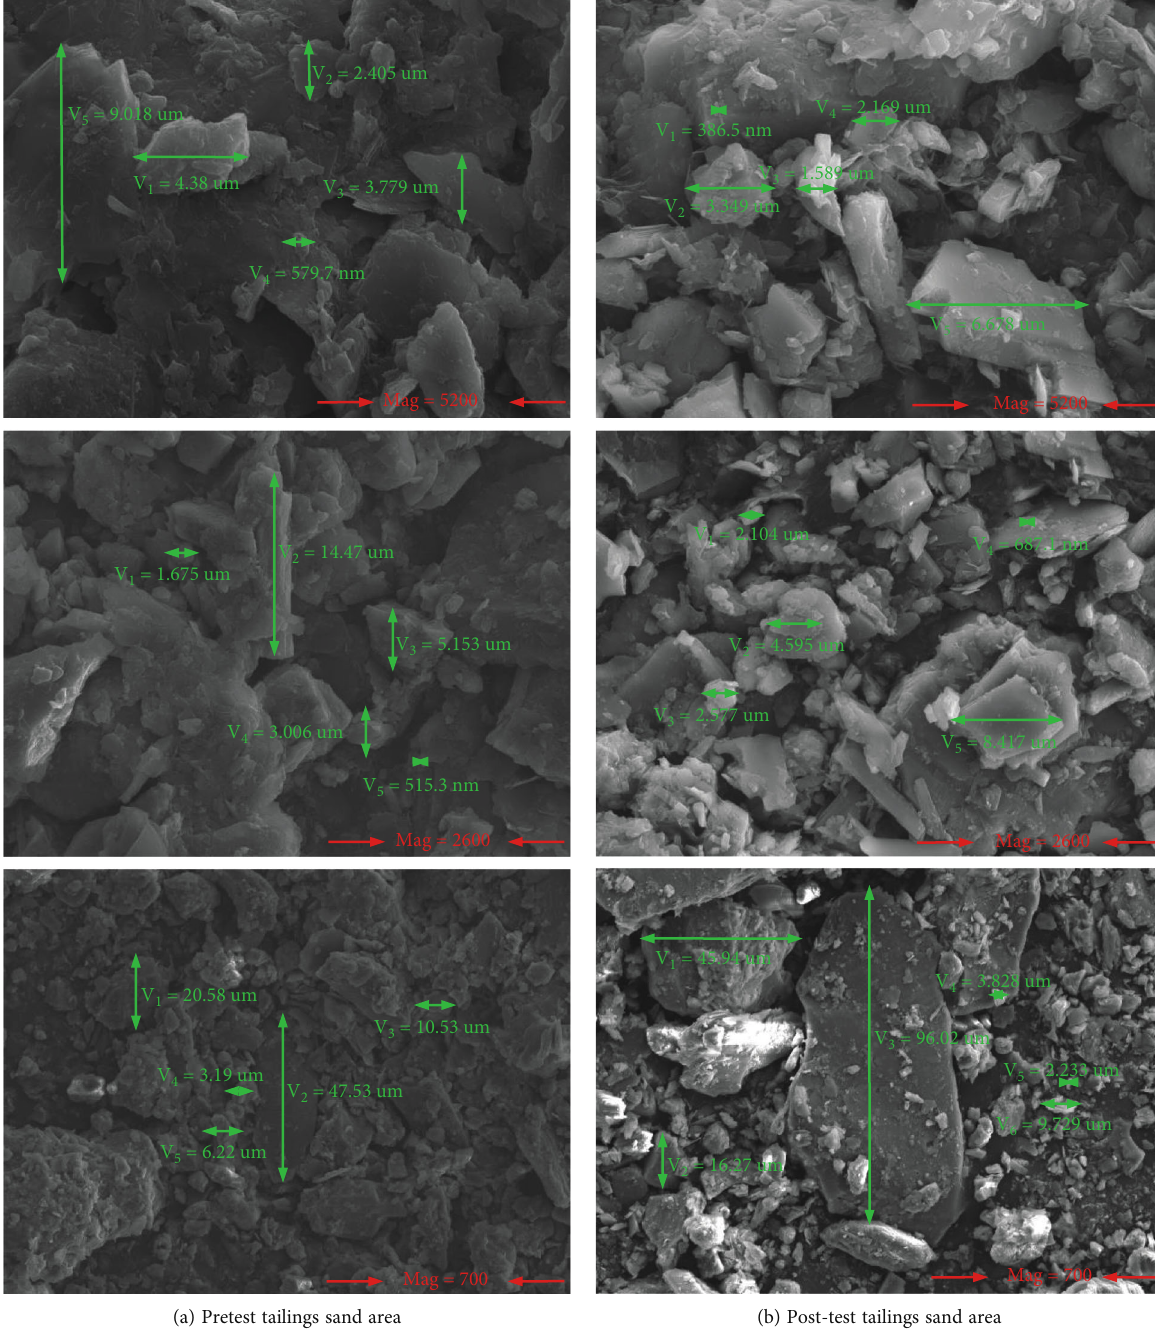
Figure 11: Scanning electron microscopy of tailing sand particles in di ff erent areas (Mag is the abbreviation of magni fi cation). Table 4: The direct shear test results of tailing